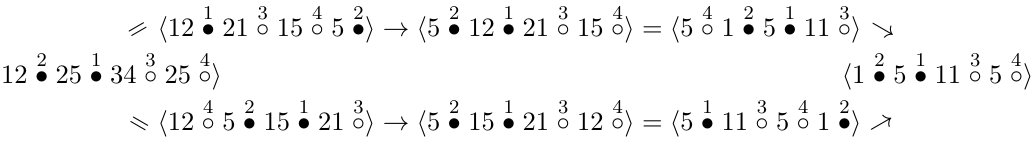
Table 1 . Two different processes of duality cascades. Both of them reduce to the same final brane